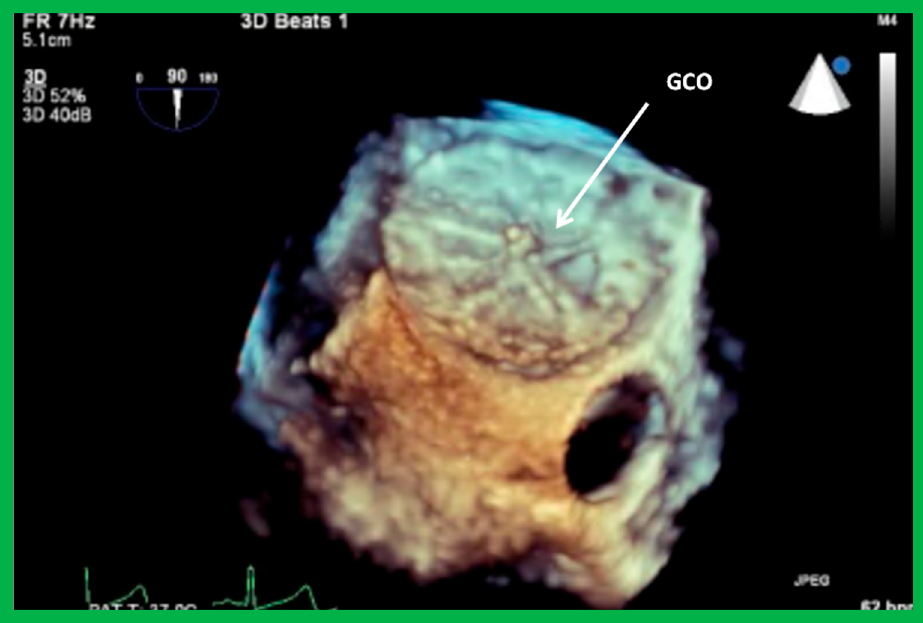
Figure 35. Three-dimensional reconstruction of transesophageal echocardiographic study showing GORE ® CARDIOFORM ASD Occluder (GCO) from the right atrial aspect, demonstrating its good position without impinging on the aortic root.